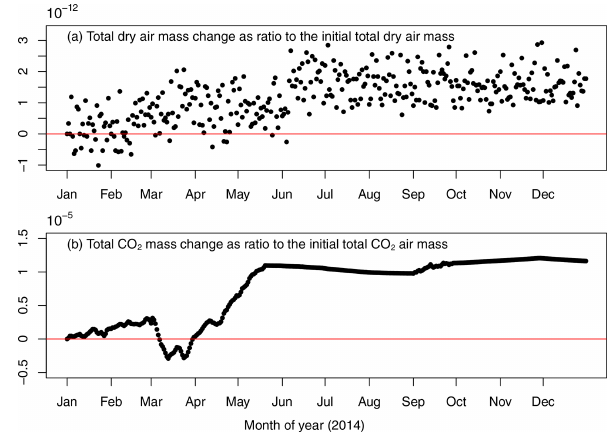
Figure 2. Variation of total dry-air mass (a) and total CO 2 mass (b) as the ratio to their respective starting values during a 1-year continuous MPAS-A simulation without meteorological re- initialization. The x axis represents the days of 2014 and the y axis the ratio of the total mass change to the starting